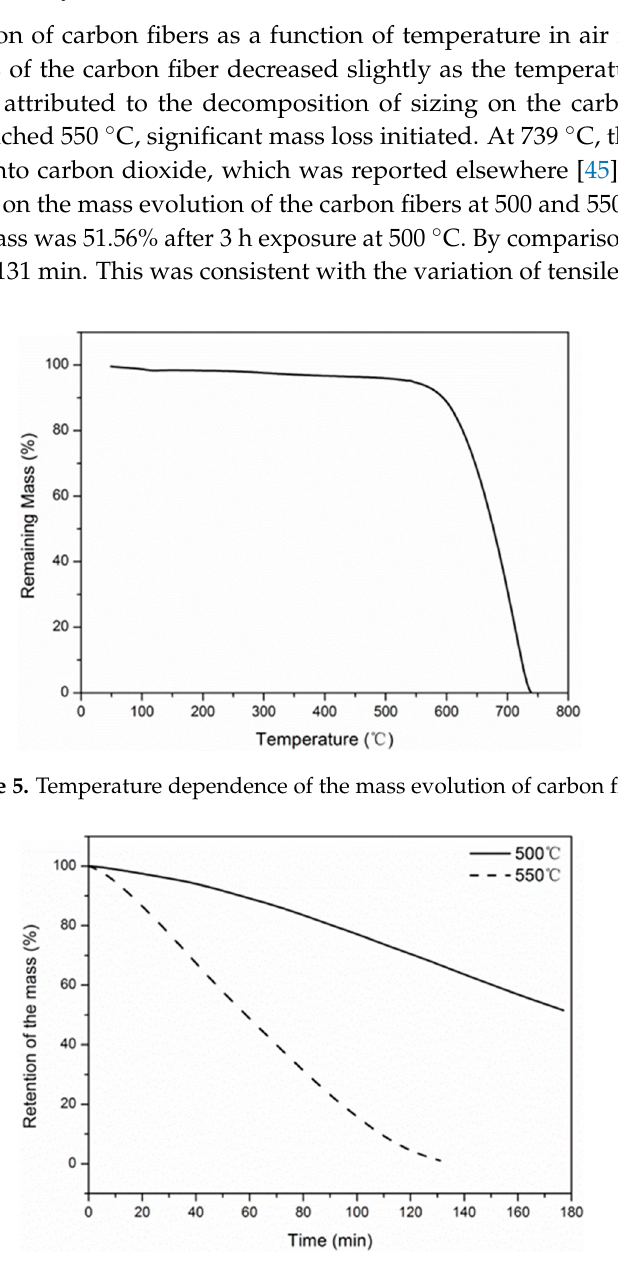
Figure 6. Time dependence of the mass evolution of carbon fiber at 500 and 550 °C.